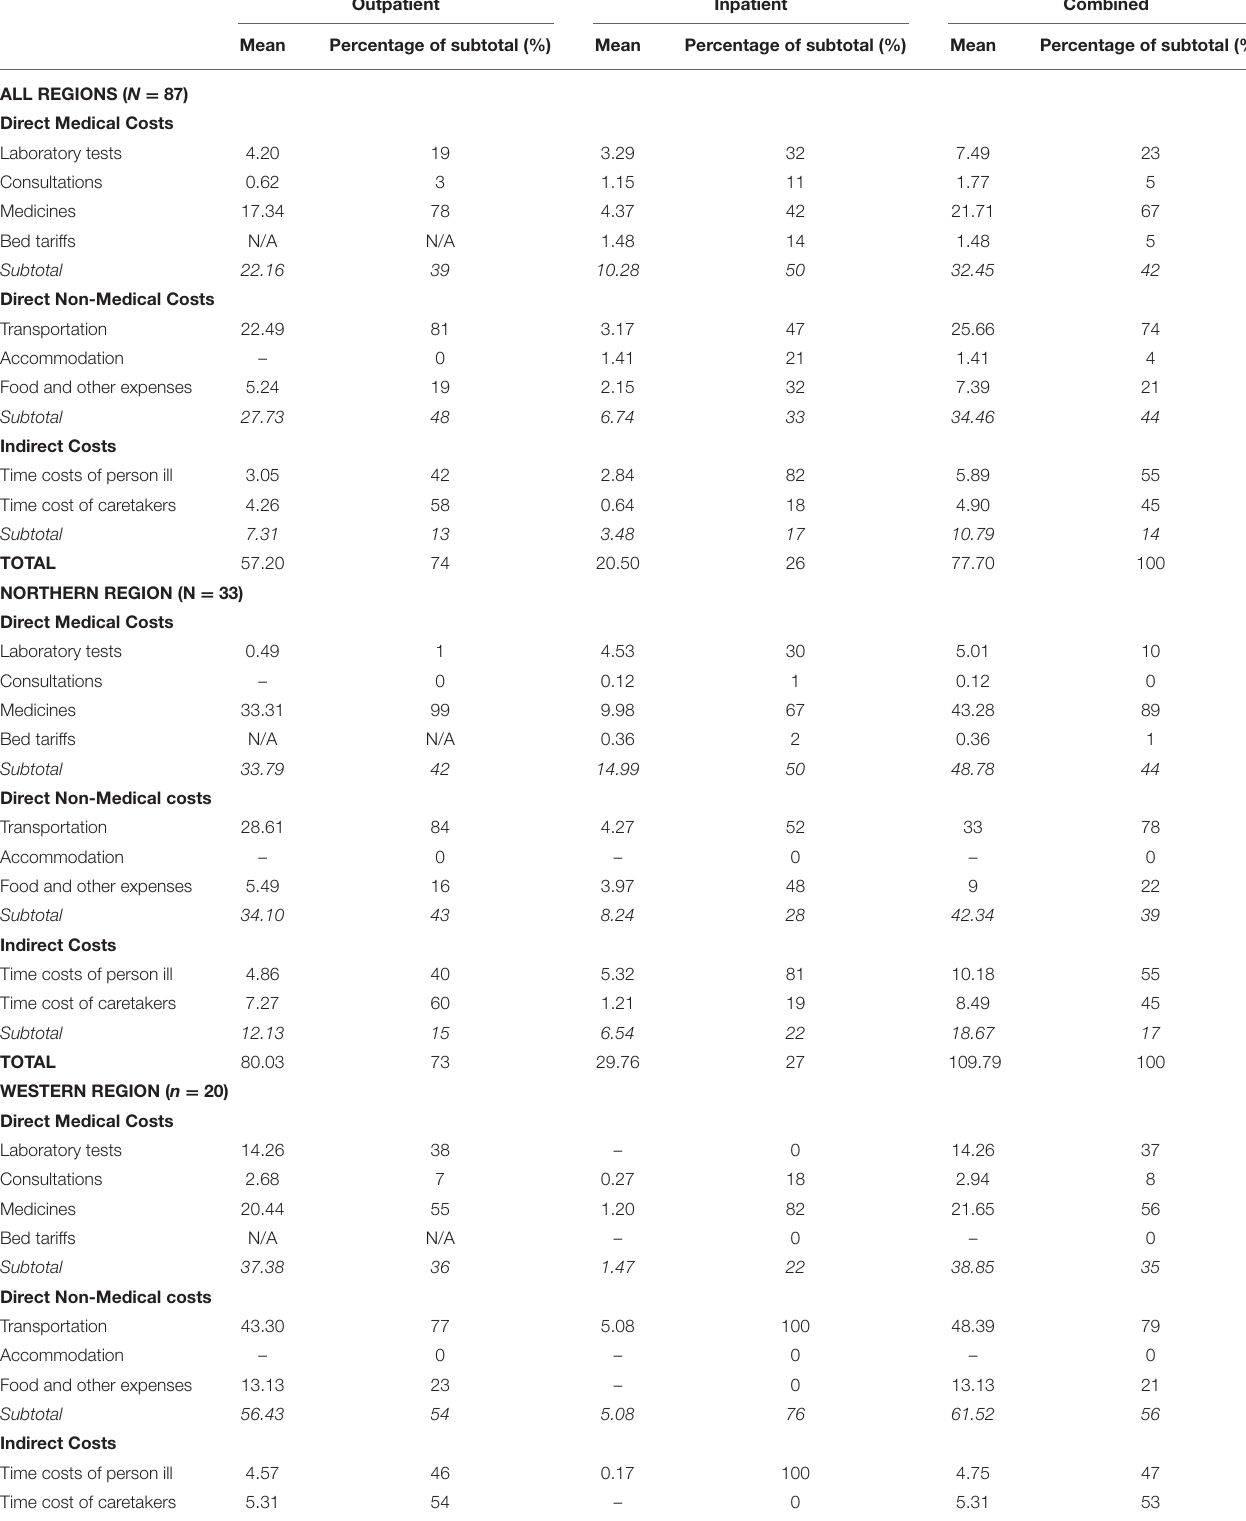
TABLE 2 | Costs a accrued from seeking RHD care. Outpatient Inpatient Combined Mean Percentage of subtotal (%) Mean Percentage of subtotal (%) Mean Percentage of subtotal